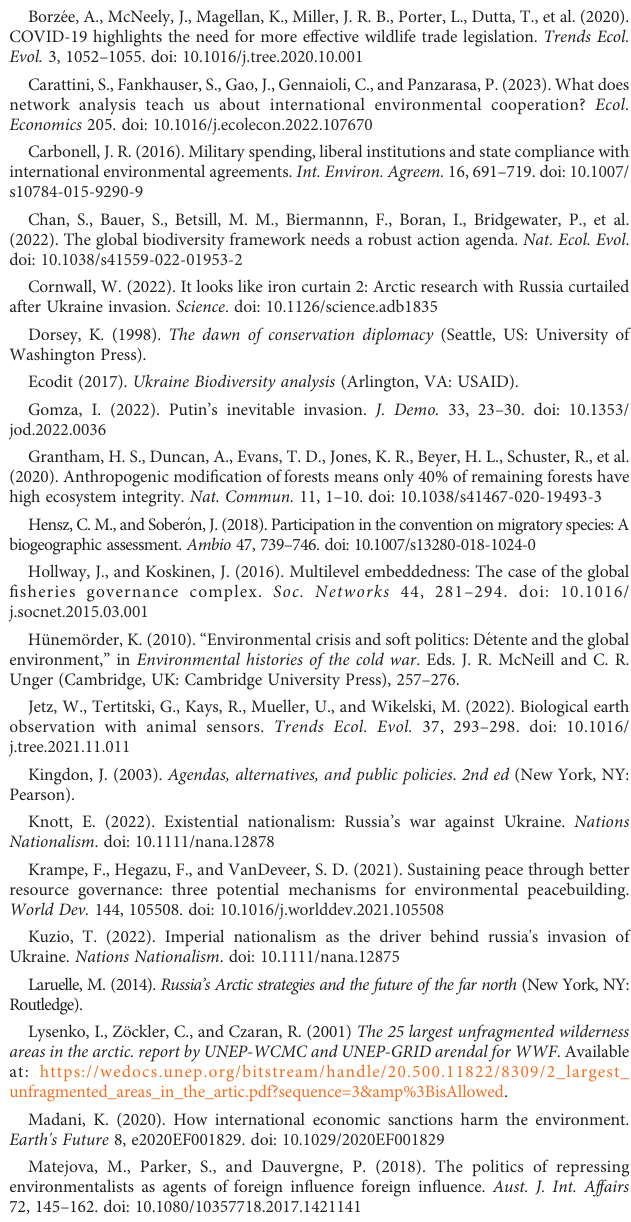
SUPPLEMENTARY DATASET 1 List of current international institutional arrangements related to biodiversity conservation to which Russia is a